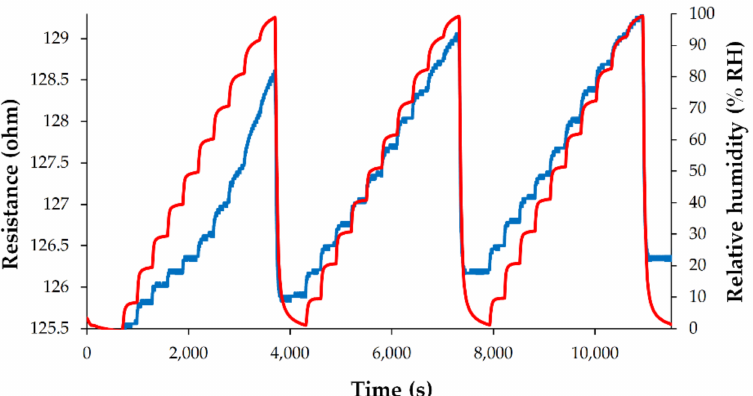
Figure 10. The response of the sensor T2 (the blue curve) as a function of time for the three measure- ment cycles when RH varies between 0% and 100%. The “RH curve-red” shows the variation of the RH in the testing chamber, as indicated by the reference sensor.